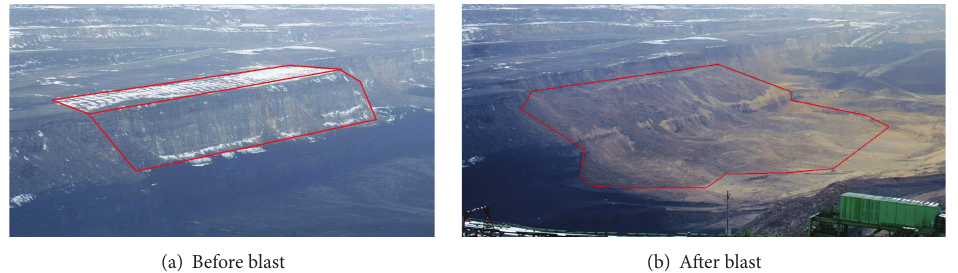
Figure 13: Blast casting technique applied in HSCM.